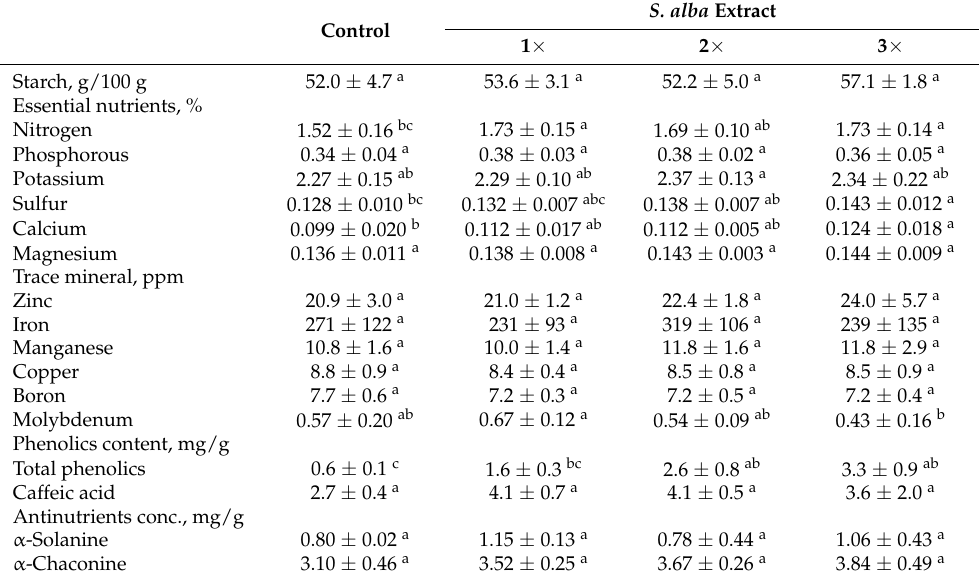
Table 2. Selected nutritional qualities of potatoes treated with one, two, and three repeated application of S. alba extract under field conditions. Values ± standard errors are the average of five replicates. Values within the same row followed by a common letter are not significantly different ( p ≤ 0.05). S. alba Extract Control 1 × 2 × 3